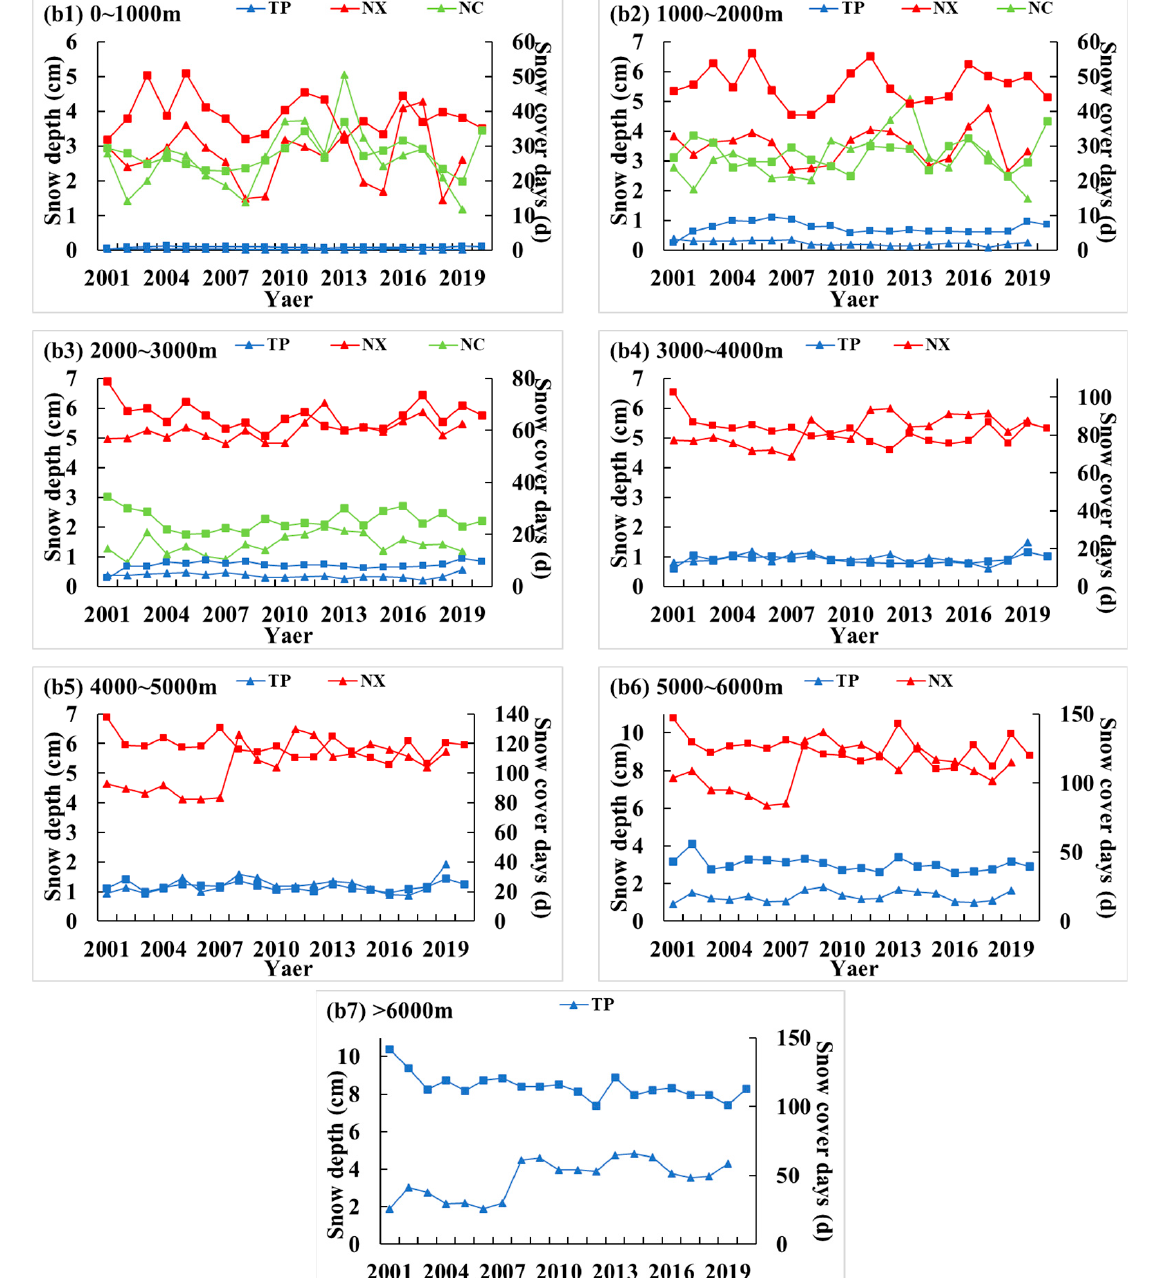
Figure 4. Annual variations in the SCF and snow cover areas ( a ) and SD and SCDs ( b ) at various altitudes in the TP, NX, and NC from 2001 to 2019 or 2020. Blue represents the TP, red represents NX, and green represents NC. In ( a ), the broken line represents the SCF, and the column represents snow cover areas. In ( b ), the triangles in the broken line represent the SD and the squares represent the SCDs.